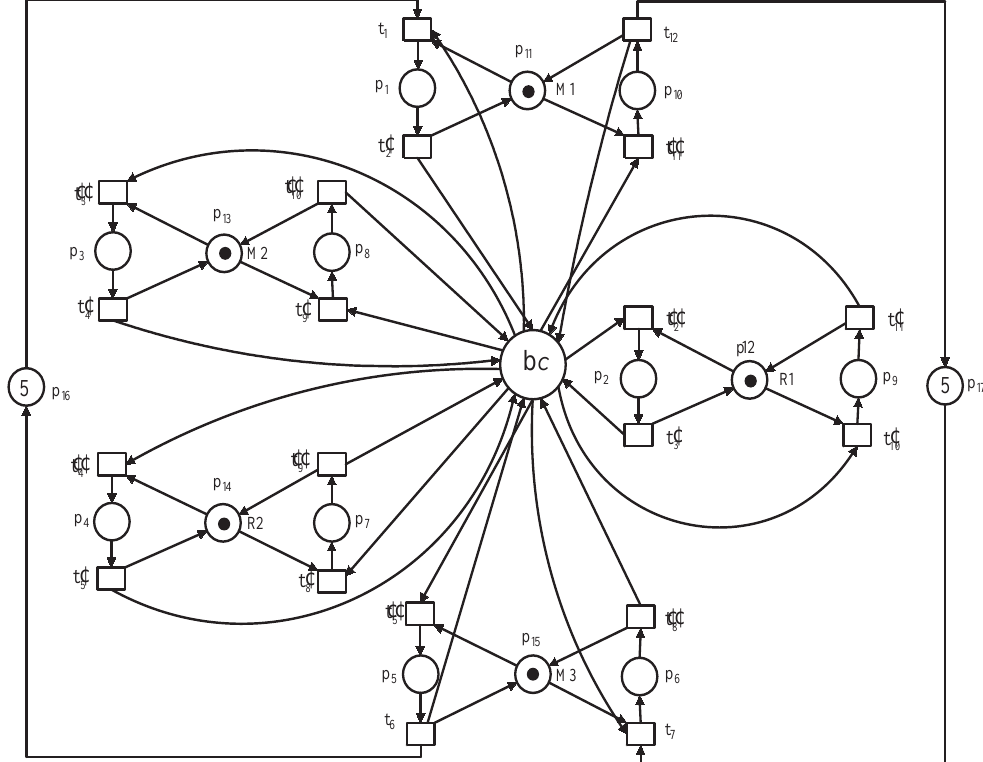
Figure 6. Controlled Petri net